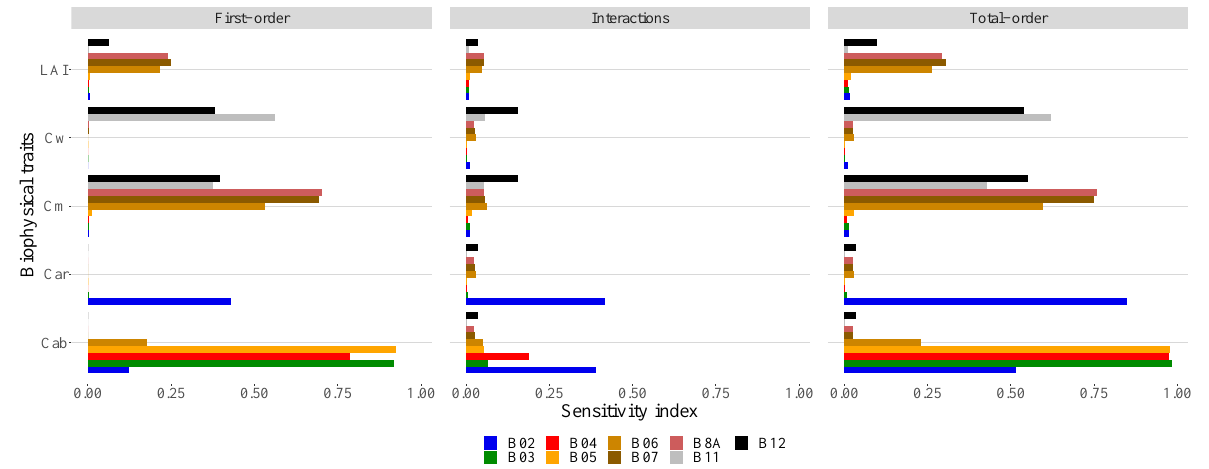
Figure 5. The sensitivity index as a function of each trait. The first-order sensitivity is the sensitivity associated with each trait while the total order is the sum of the first order with the